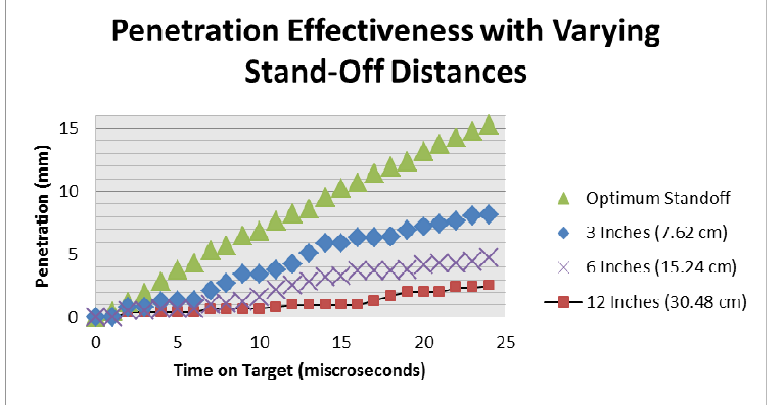
Figure 8. Penetration effectiveness at different standoff